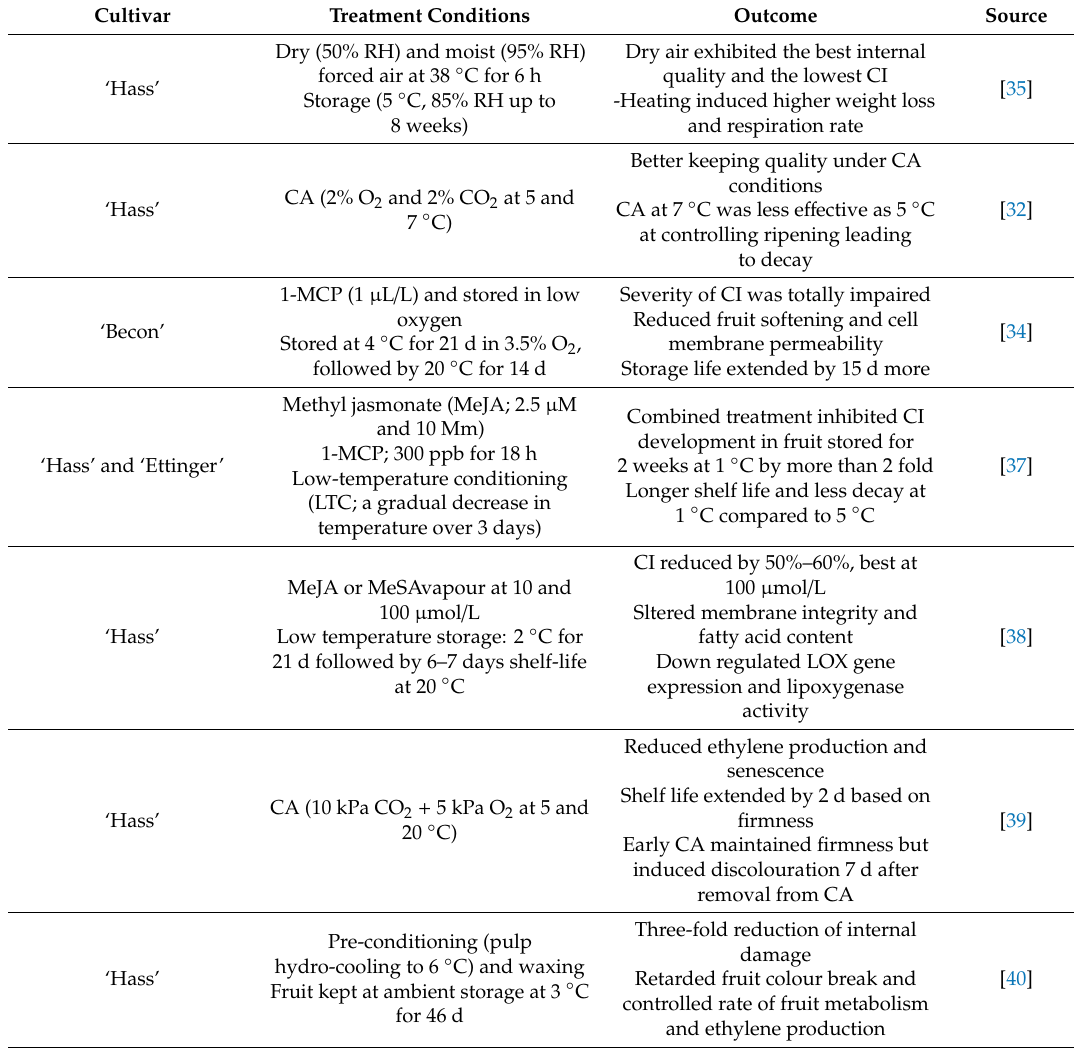
Table 2. Measures to control chilling disorders of